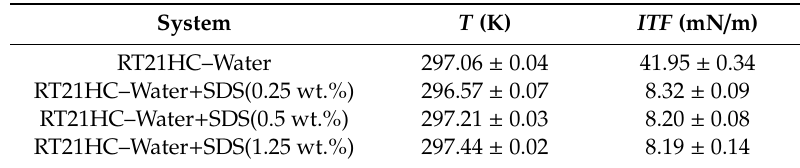
Table 2. Interfacial tensions, ITF , between bulk–RT21HC and water or between bulk–RT21HC and the three water + SDS mixtures experimentally measured at room